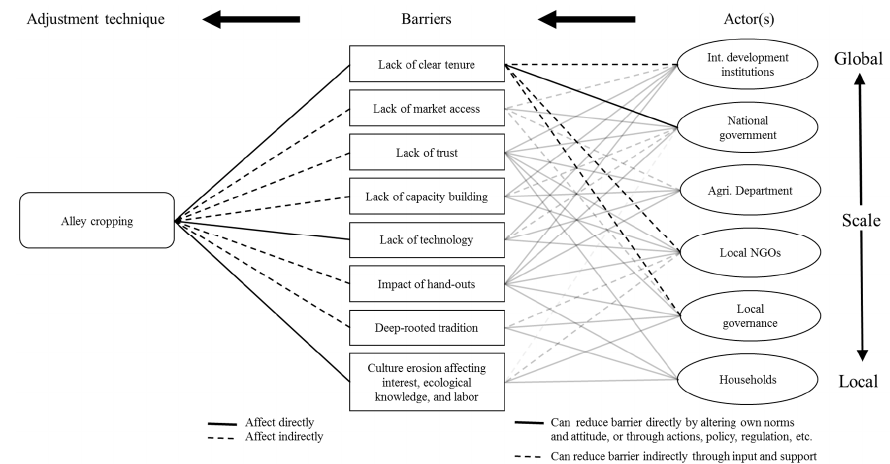
Figure 3. Flowchart showing the complexity and interaction of barriers for adoption of alley cropping in Belize. The arrows at the top indicate the direction of impact (i.e., right to left). Right side: connections indicate which actor(s) should potentially be involved in order to reduce barriers in adopting the suggested adjustment. Left side: the connections shows which barriers affect (directly or indirectly) implementation of the adjustment. All connections are potential and are not valid for all villages. The black lines illustrate the example described in the text.